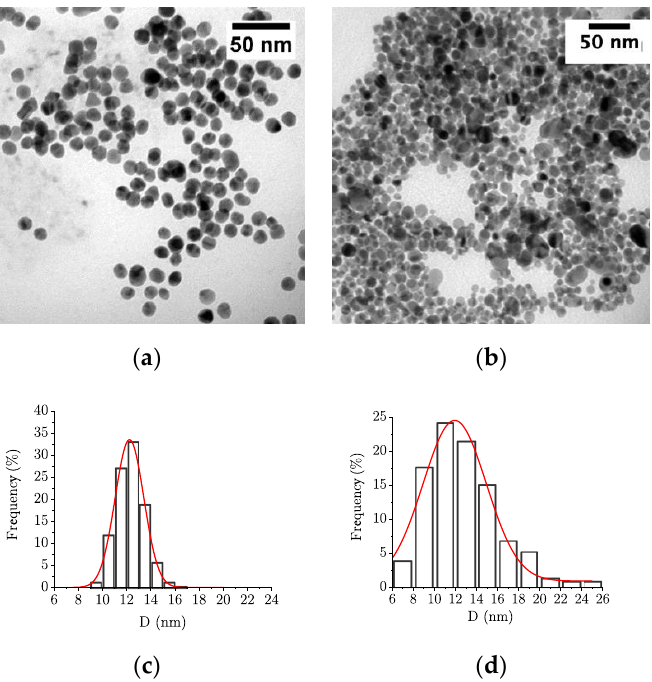
Figure 6. TEM micrographs and size distributions of ( a , c ) AuNPs and ( b , d ) AgNPs in